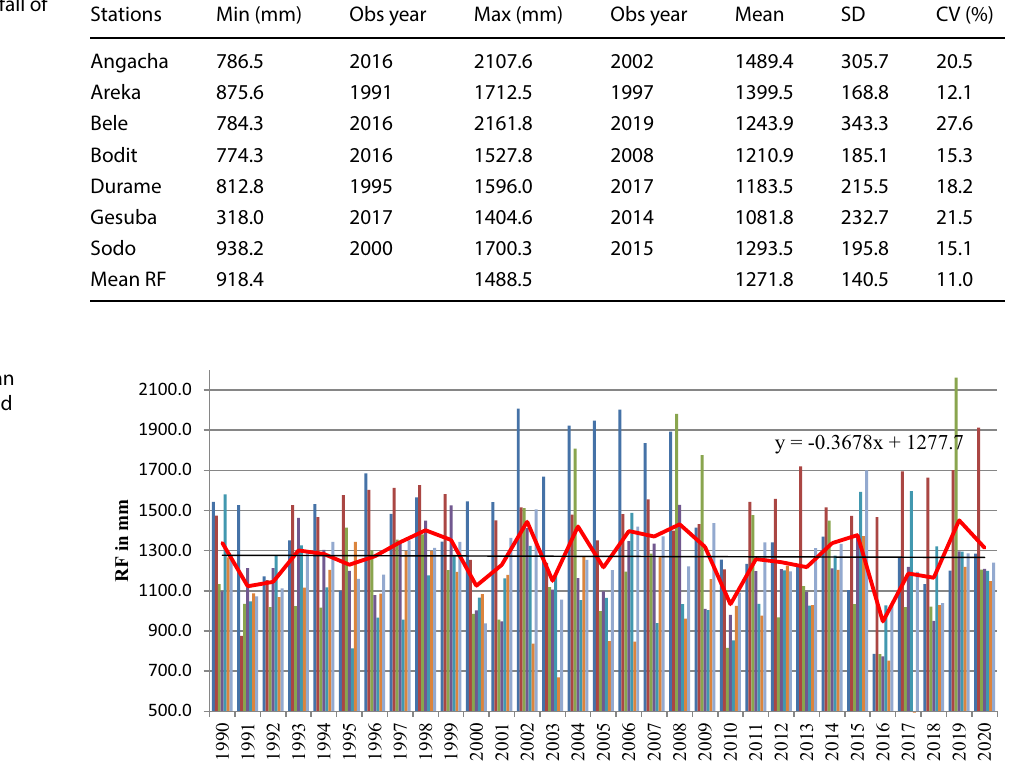
Table 3 Mean annual rainfall of the watershed